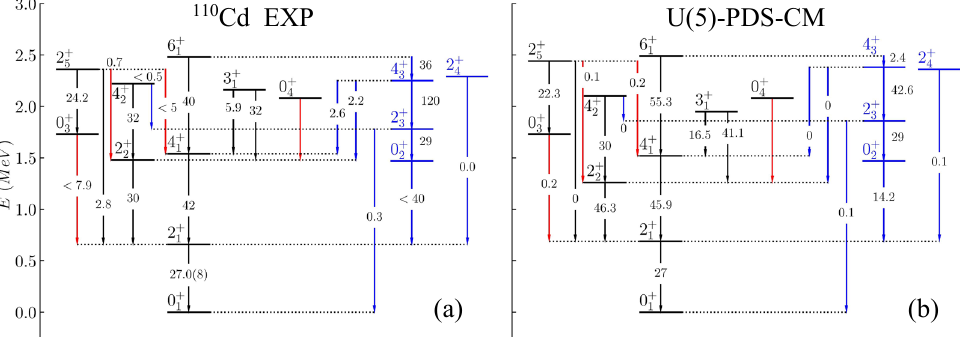
t 3 = 73 . 6 , t 4 = 18 . 5 , r 0 = −